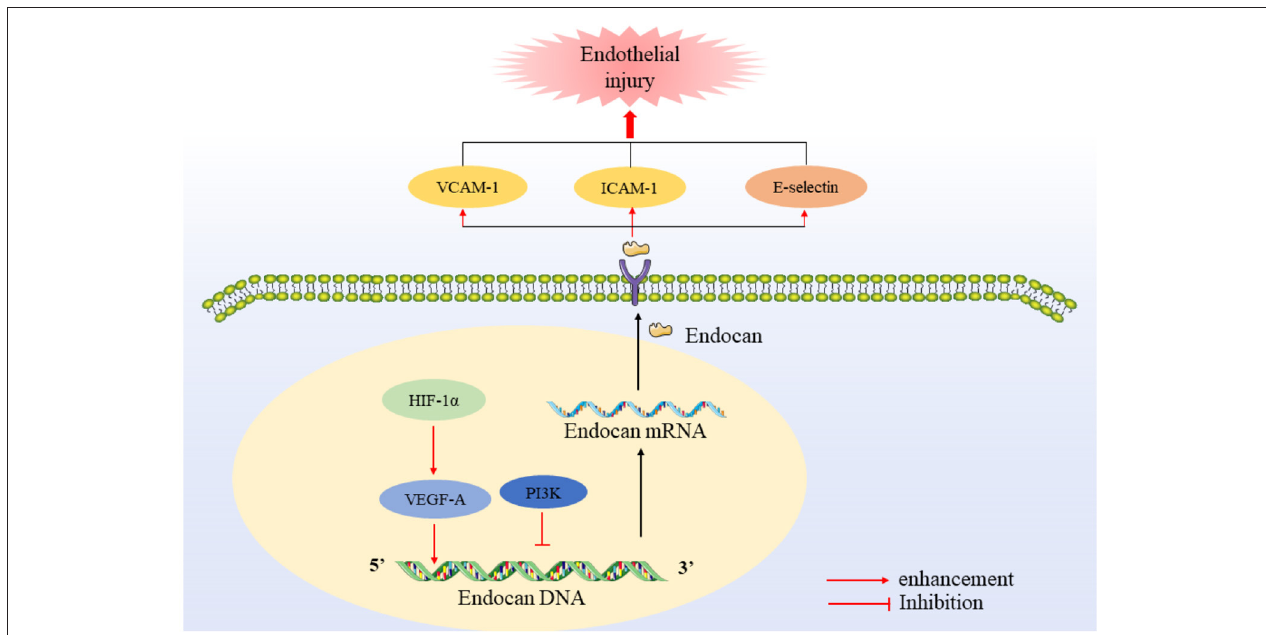
FIGURE 2 | Regulation and expression of endocan. HIF-1 promotes endocan mRNA expression and transcription through VEGFA, while PI3K has the opposite effect. After being secreted, endocan promotes the up-regulation of the levels of VCAM, ICAM and